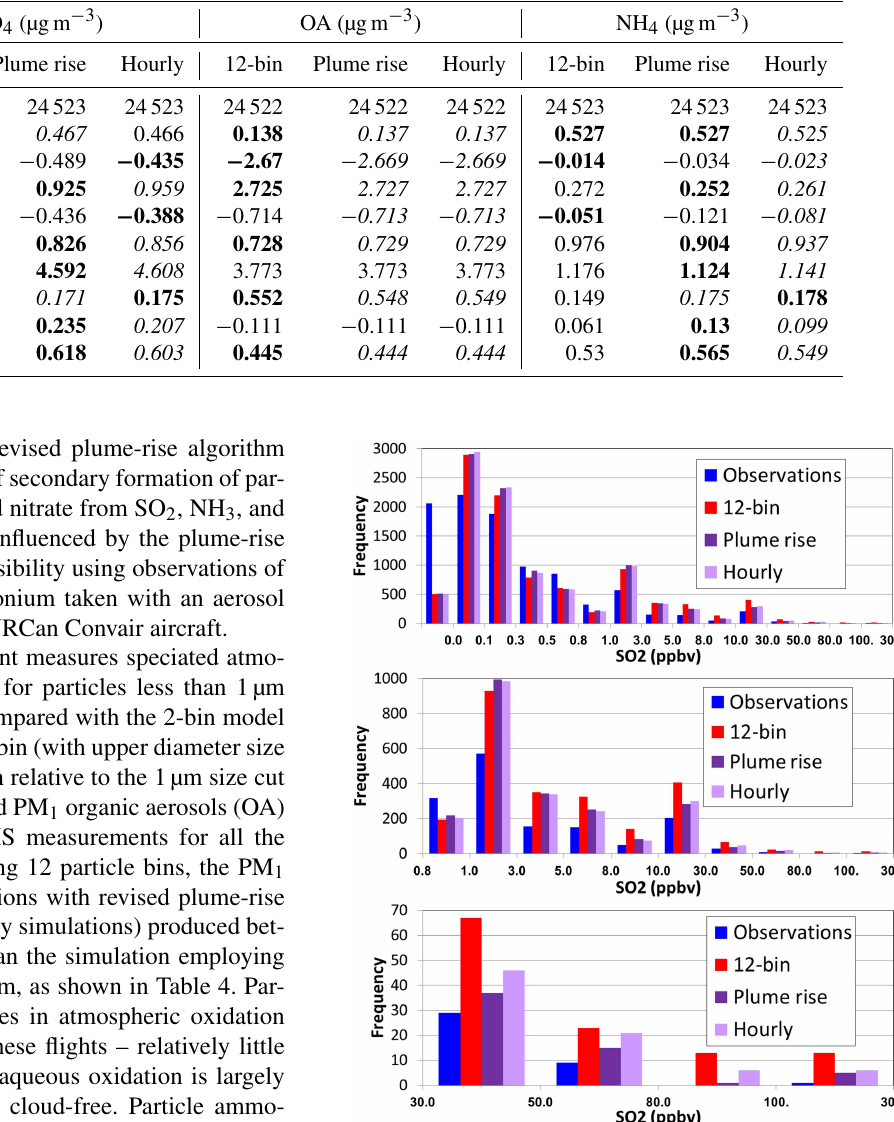
Figure 4. Histograms of hourly surface SO 2 mixing ratios, in log- arithmic mixing ratio bins, observations (blue), original plume-rise algorithm (red), revised plume-rise algorithm (dark purple), revised plume-rise algorithm driven by hourly CEMS stack data (light pur- ple). (a) All values; (b) 0.8 to 300ppbv; (c) 30 to 300ppbv.